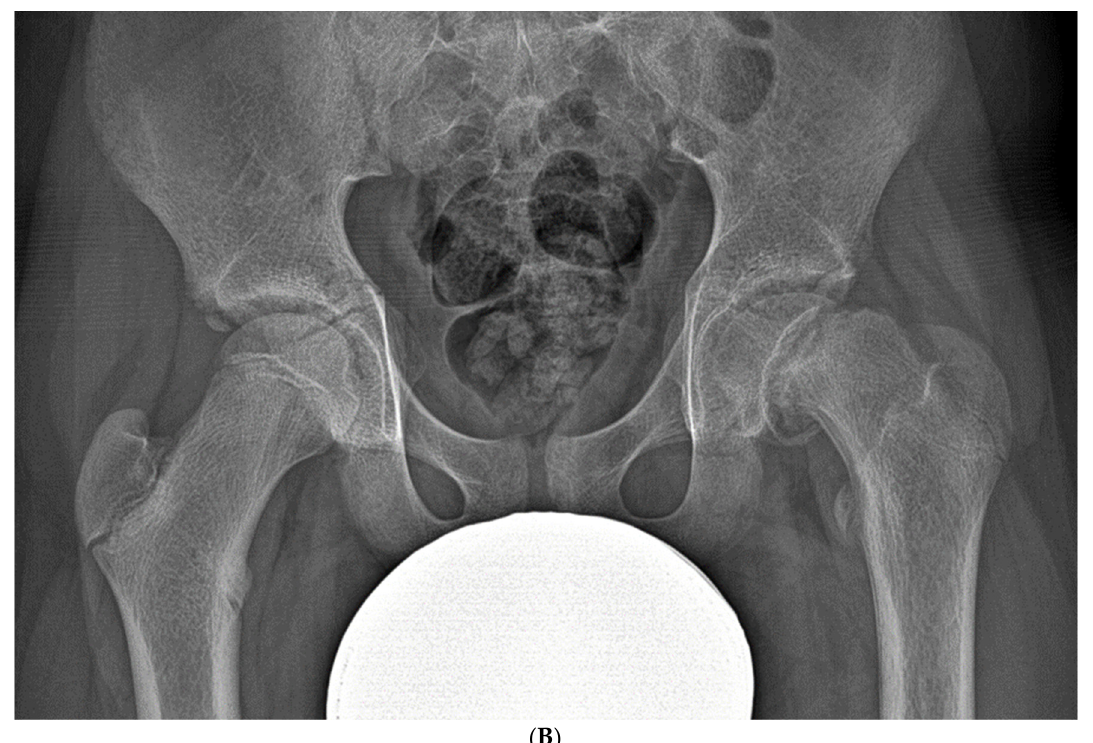
Figure 14. ( A ) A case of exfoliation of the femoral head in a 13-year-old boy. Images are in the plane of the long axis of the femoral neck. Image of healthy right hip joint (right); exfoliation of the left femoral head (left). Arrows—level of growth plate of the femoral head; arrowheads—proximal femoral epiphysis. Accompanying exudate (dotted line) is visible in the left hip joint. Linear probe 3–19 MHz. Figure 14. ( B ) X-ray image of the same patient. Visible exfoliation of the left femoral head.